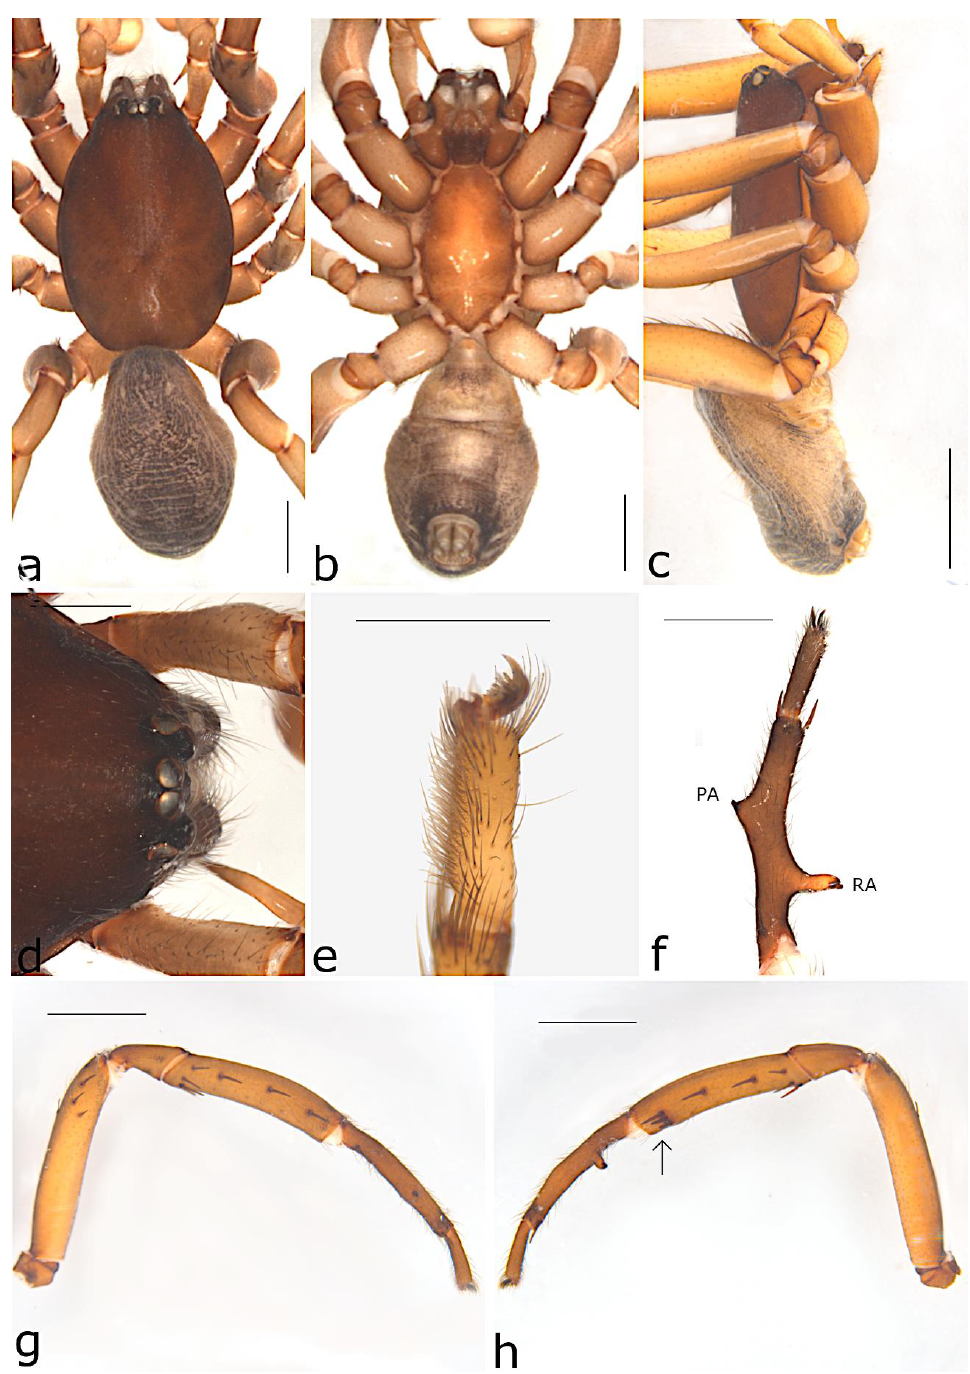
Figure 57. Ariadna tangara Marsh, Baehr, Glatz & Framenau, 2018. ♂ holotype (SAMA NN29863) from Kangaroo Island (SA): ( a ) habitus, dorsal view; ( b ) same, ventral view; ( c ) same, lateral view; ( d ) eyes, dorsal view; ( e ) left metatarsus IV, preening comb, retrolateral view; ( f ) left leg I, ventral view; ( g ) same, prolateral view; ( h ) same, retrolateral view, arrow indicating group of macrosetae on raised base. Scale bars ( a – h ) = 1 mm.